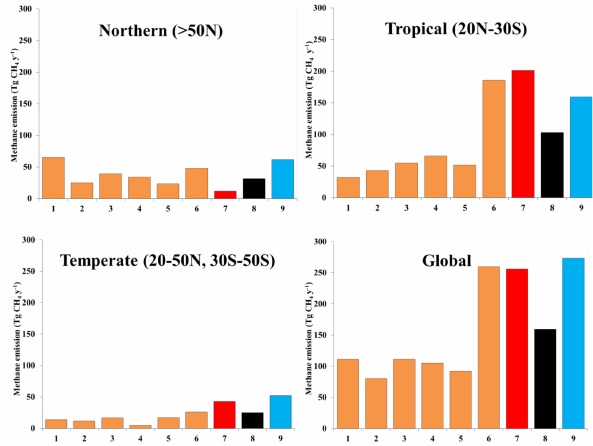
Fig. 15. Comparison of total CH 4 emissions (Tg CH 4 yr − 1 ) between our model and other models’ estimations from natu- ral wetlands. 1: Matthews and Fung (1987), 2: Aselmann and Crutzen (1989), 3: Bartlett et al. (1990), 4: Bartlett and Har- riss (1993), 5: Cao et al. (1996), 6: Walter et al. (2001), 7: the CLM4Me’ (this study), 8: Bousquet et al. (2006); 9: the CLM4Me model (Riley et al., 2011). Red indicates the CLM4Me’ and Black is a top-down inversion. Please note that estimates from the CH4Me (9) may include rice paddy emissions since the rice paddy fraction was not removed from model-simulated inundated fraction. Also, soil sink is included in the CLM4Me’ and CLM4Me, but is excluded in other